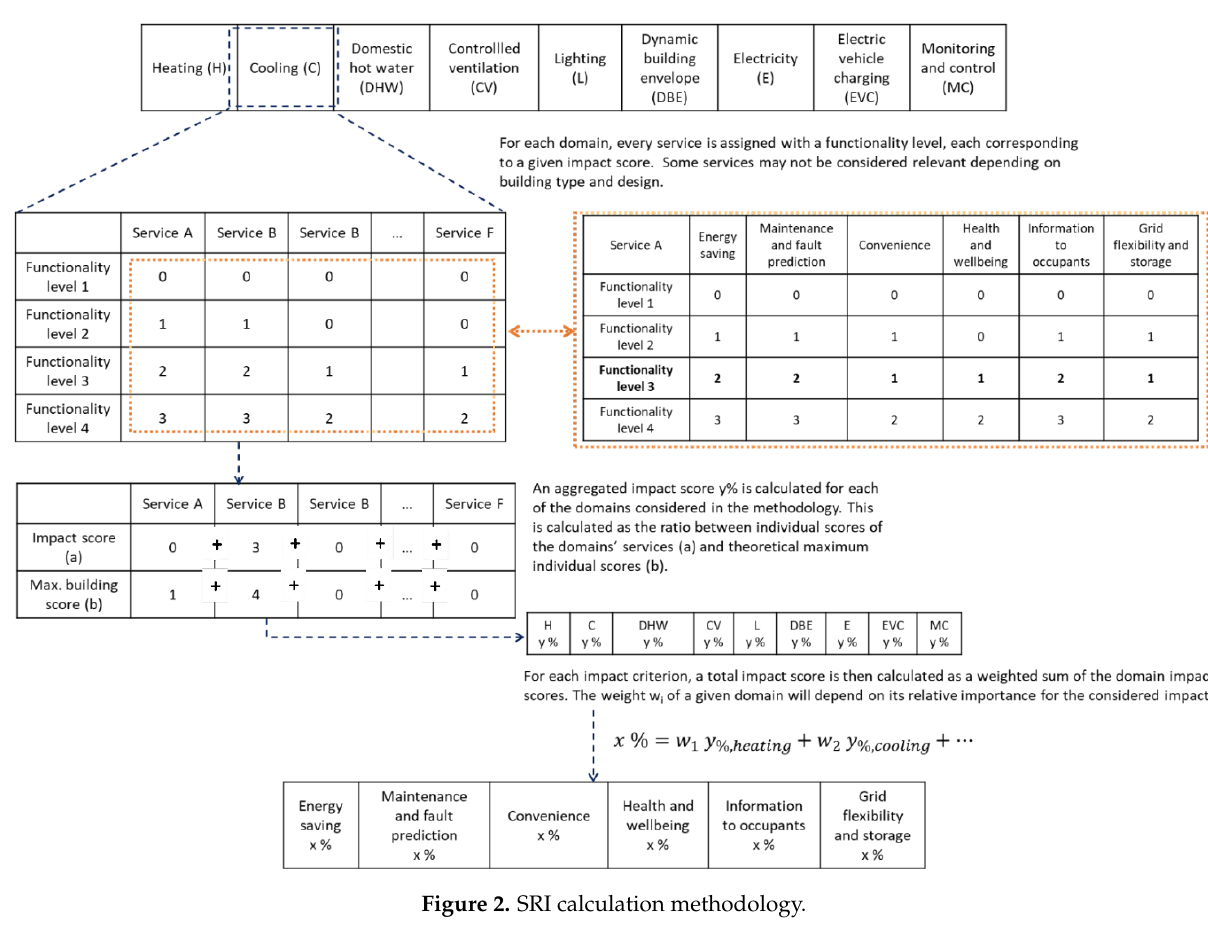
Figure 2. SRI calculation methodology.